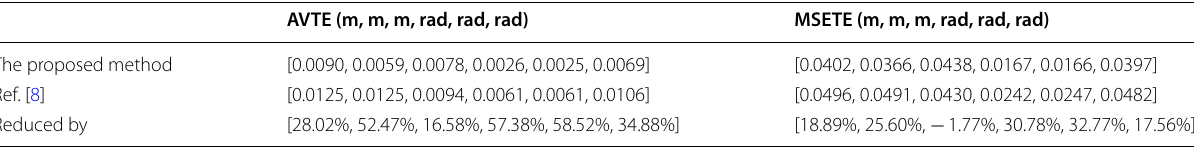
Table 3 Simulation data in 0.3 m/s ocean current environment